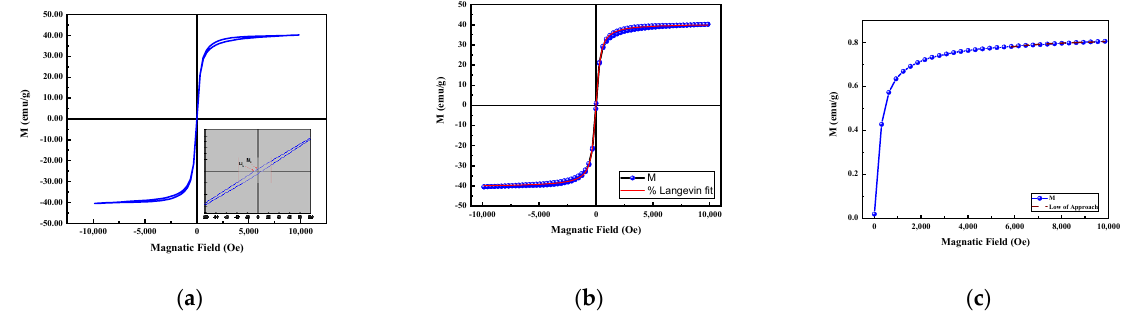
Figure 4. ( a ) Hysteresis loop at room temperature; ( b ) fitting of the experimental magnetization with the Langevin function; and ( c ) the saturation law.